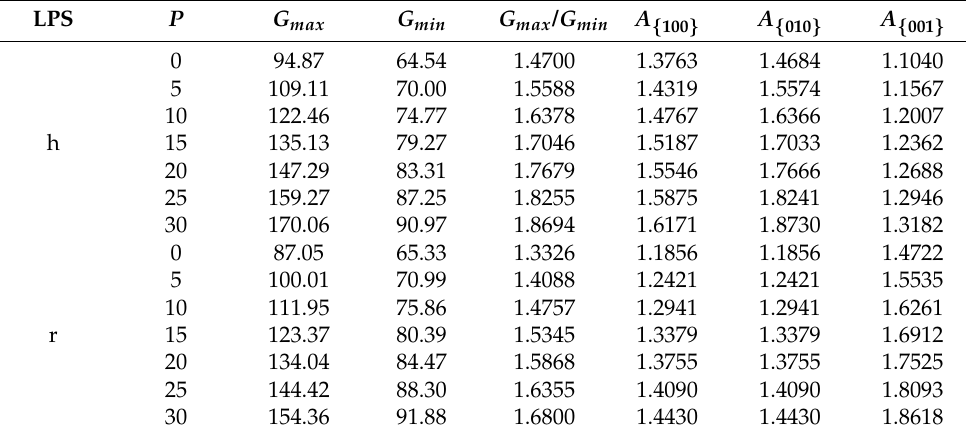
Table 6. Calculated maximal ( G max ) and minimal ( G min ) values of shear modulus, the ratio of the two extremes ( G max / G min ), and shear anisotropic factors ( A { 100 } , A { 010 } , A { 001 } ) for the LPSs h- and r-Al 2 Ti under pressure up to 30 GPa at 0